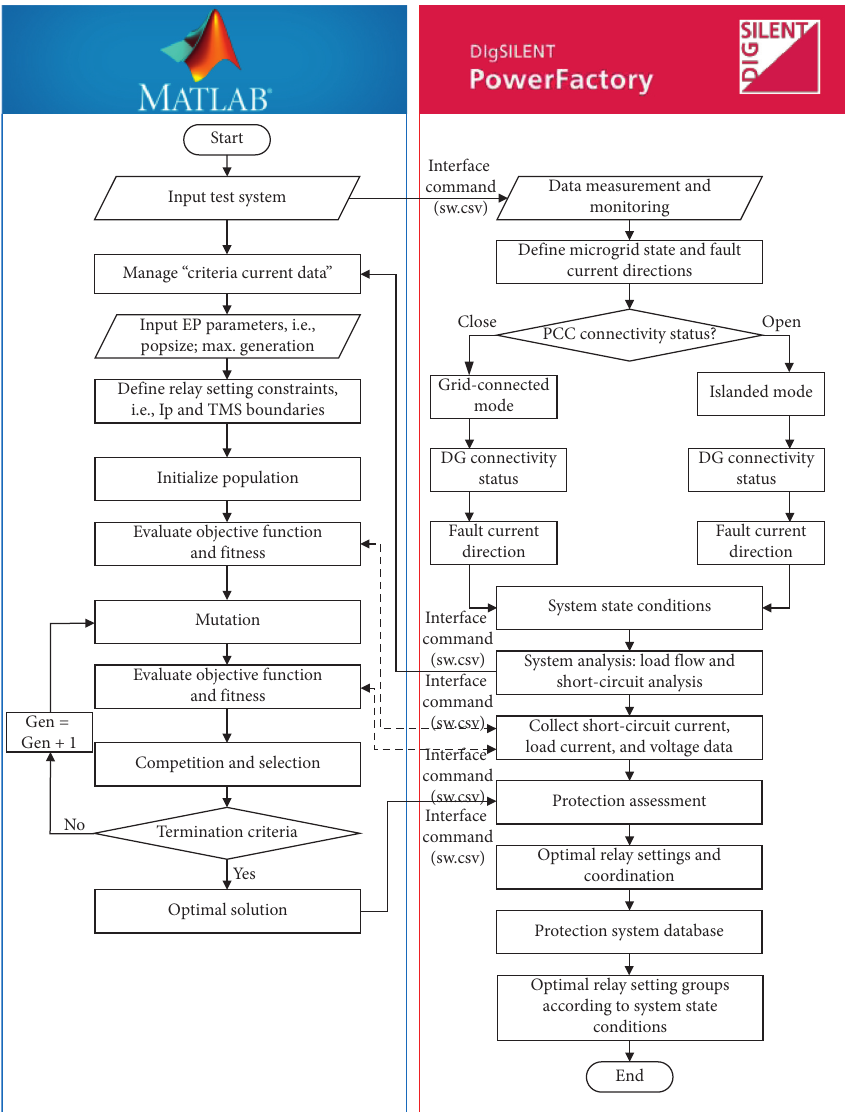
Figure 5: Flowchart of the optimal dual-DOCR setting and